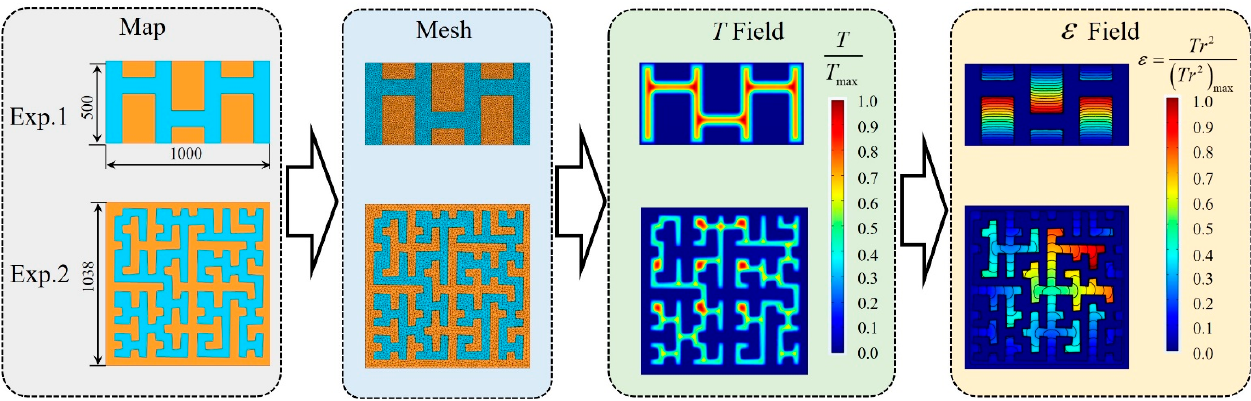
Figure 4. OIR flow charts of two examples in Section 6.